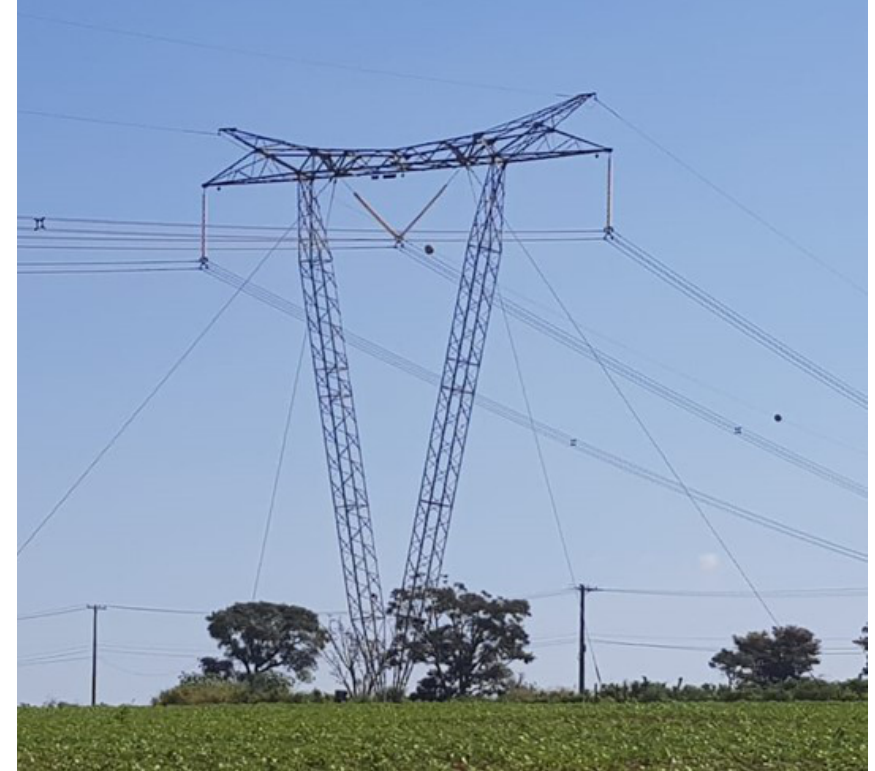
Figure 1. Typical guyed-V steel lattice tower commonly seen in the Brazilian power